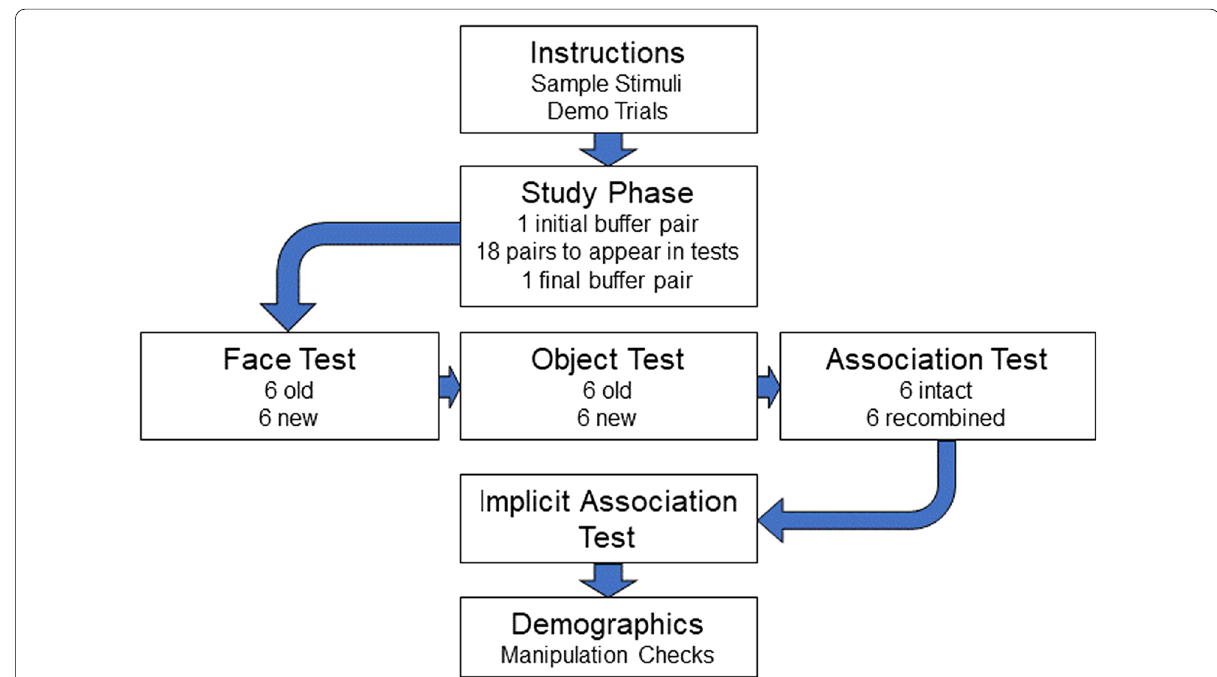
Fig. 1 Schematic portraying general flow of events in each experimental session. Recognition data were collected in six experimental blocks featuring a study phase and the three test phases. Test phase order was counterbalanced among